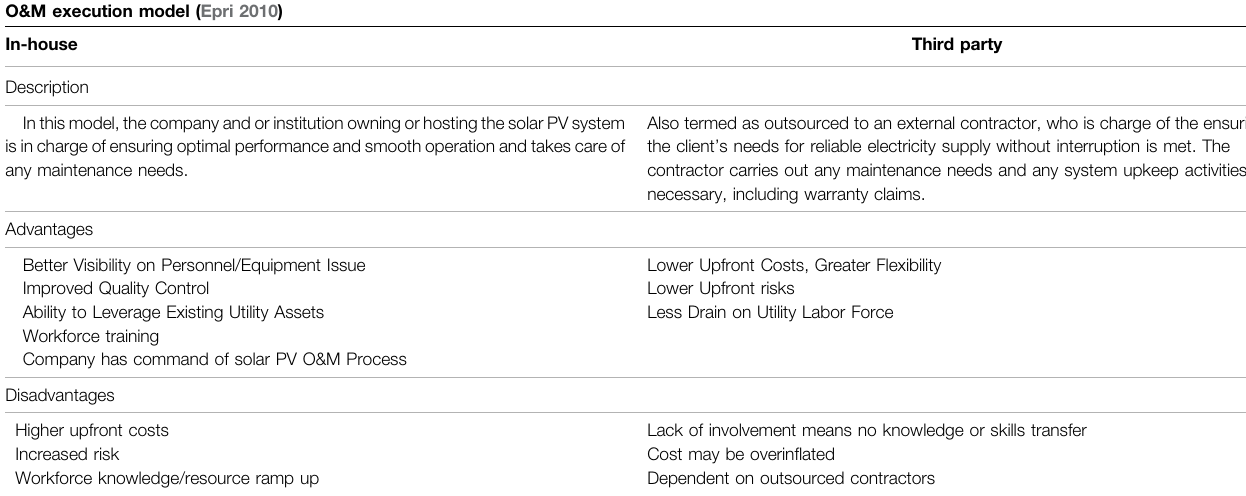
TABLE 3 | Different models for handling operation and maintenance